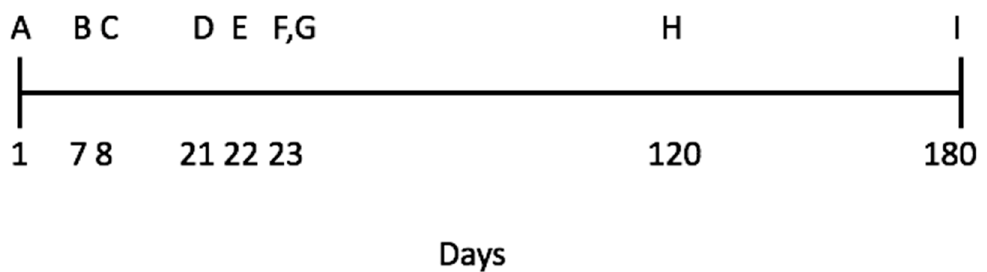
Figure 2. The experiment timeline. This study was conducted over 180 days following this timeline sequence: A: collection of faecal samples to determine basal faecal glucocorticoid metabolite concentration; B: temperament assessment (novel object test); C: training sessions for the judgement bias test (JBT); D: the first JBT; E: modified defence test battery (MDTB); F: the second JBT; G: the second collection of faecal samples to determine faecal glucocorticoid metabolite concentration, (F and G both occurred 24 h after the MDTB); H: temperament assessment (novel-environment test); I: temperament assessment (anti-predator test).